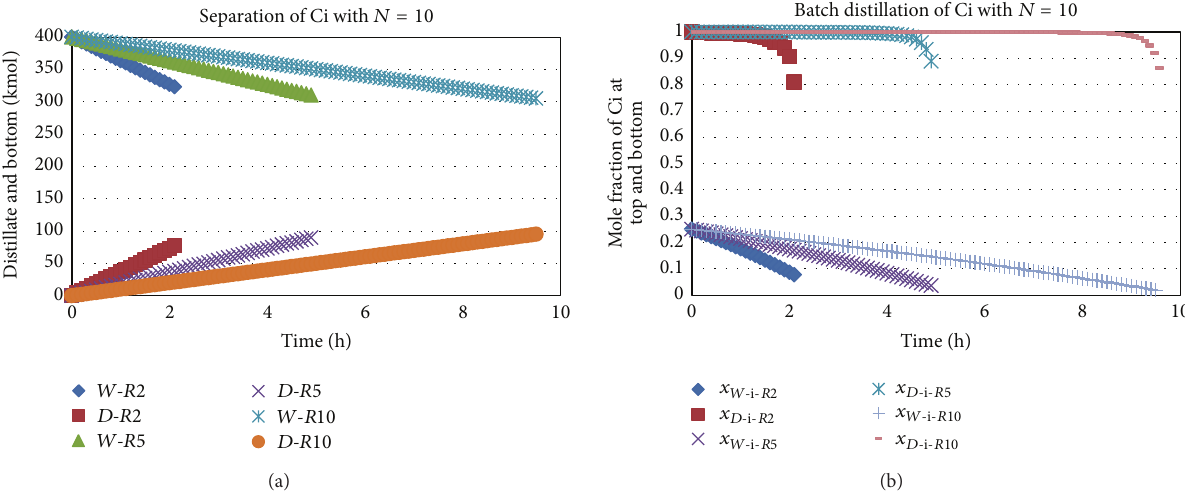
Figure 3: Results for four components batch distillation at reflux ratios of 2, 5, and 10 for a column with 10 theoretical stages.